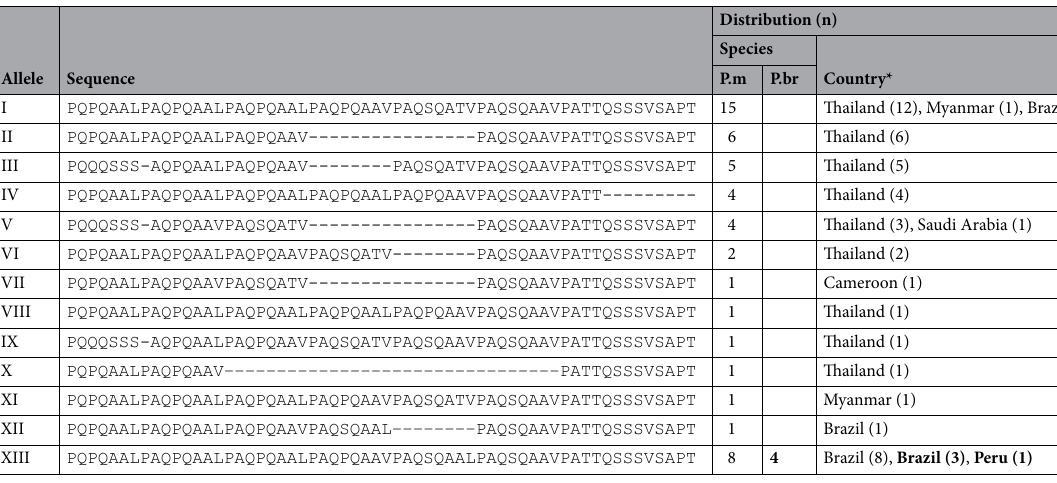
Table 3. Distribution of alleles in block VIII of PmMSP1 and PbrMSP1 . P.m and P.br denote Plasmodium malariae and P. brasilianum , respectively. Dash indicates a deletion. Thai isolates and GenBank accession numbers of isolates elsewhere are (I) PM1, PM2, PM10, PM14, PM20–27; KX672048, KR072259 and KR072258; (II) PM3–PM7; (III) PM11, PM12 and PM28–PM30; (IV) PM16–PM19; (V) PM31, PM34, PM35 and FLQW01000468, (VI) PM32 and PM33; (VII) FJ824669; (VIII) PM9; (IX) PM13; (X) PM15; (XI) KX672047; (XII) KR072262; (XIII) KR072254–KR072257, KR072260–KR072263, KR072265–KR072268 and KY189272. *Bolds are countries for P. brasilianum .